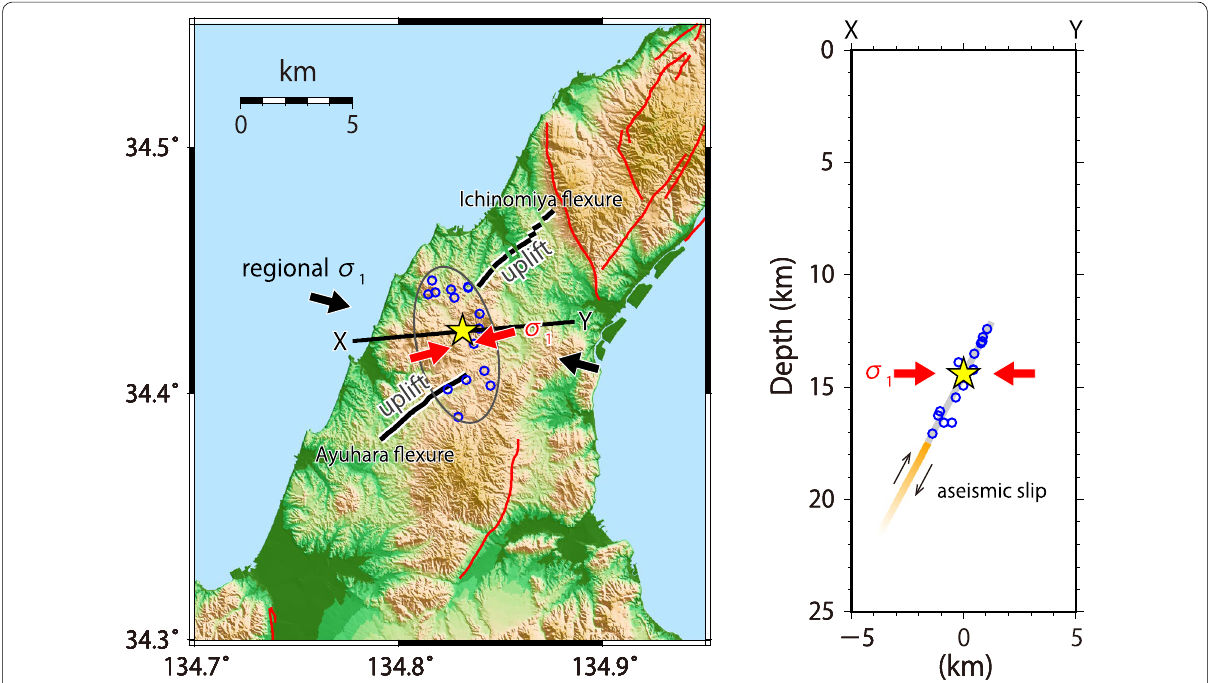
Fig. 13 Local seismotectonics causing stress heterogeneity in the source region of the 2013 Awaji Island earthquake. A yellow star shows the hypocenter of the mainshock. The red lines show the surface traces of active faults (Nakata and Imaizumi 2002), and the black lines show Ichinomiya and Ayukawa flexures (Takahashi et al. 1992). The red and black arrows show the orientation of the maximum principal stress in the source region and in the surrounding area, respectively. Blue circles represent the on-fault aftershocks. The line X – Y is perpendicular to the strike of the mainshock fault plane. Topography is based on a 10 m grid digital elevation model published by the Geospatial Information Authority of